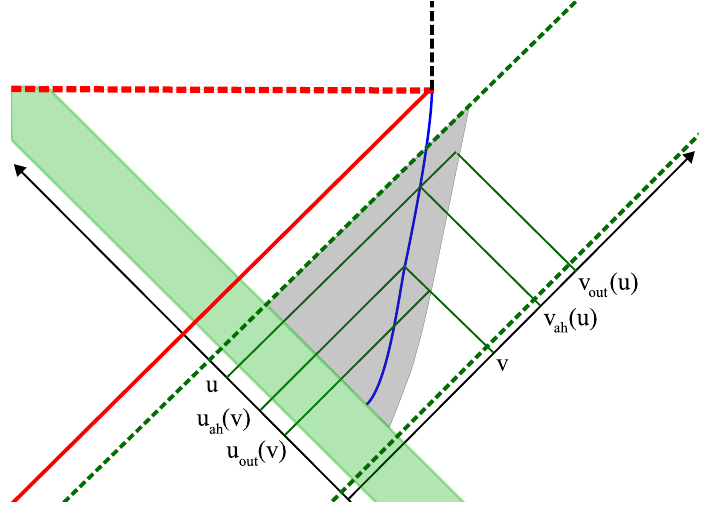
Figure 2. A part including the near-horizon region (gray shade) is excerpted and enlarged from Figure 1a. Axes of the ( u , v ) coordinates are added to show the meaning of the notation u ah ( v ) , u out ( v ) , v ah ( u ) , and v out ( u ) for an example of a pair of u and v